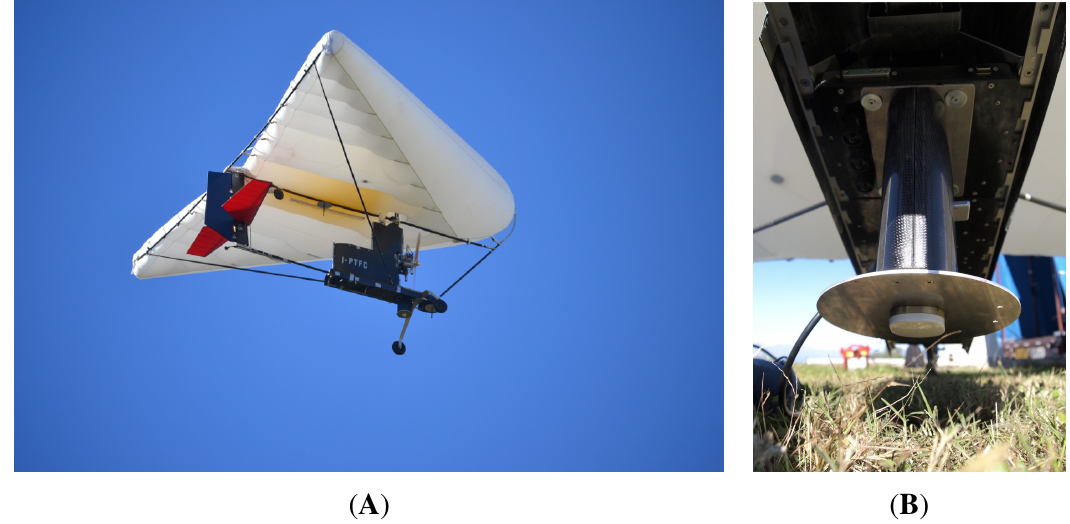
Figure 9. Sensor prototype mounted on the Nimbus C-Fly UAV during the flight ( A ) and on the ground after landing ( B